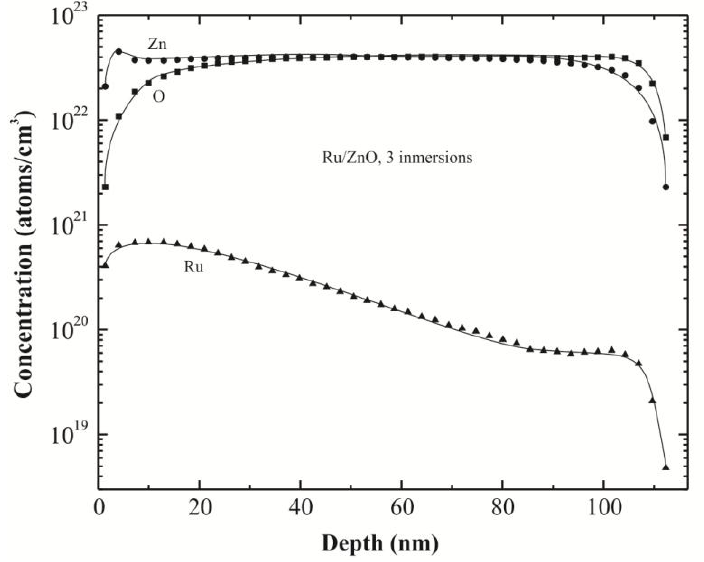
Figure 5. SIMS depth profiles for the three immersions ZnO:Ru